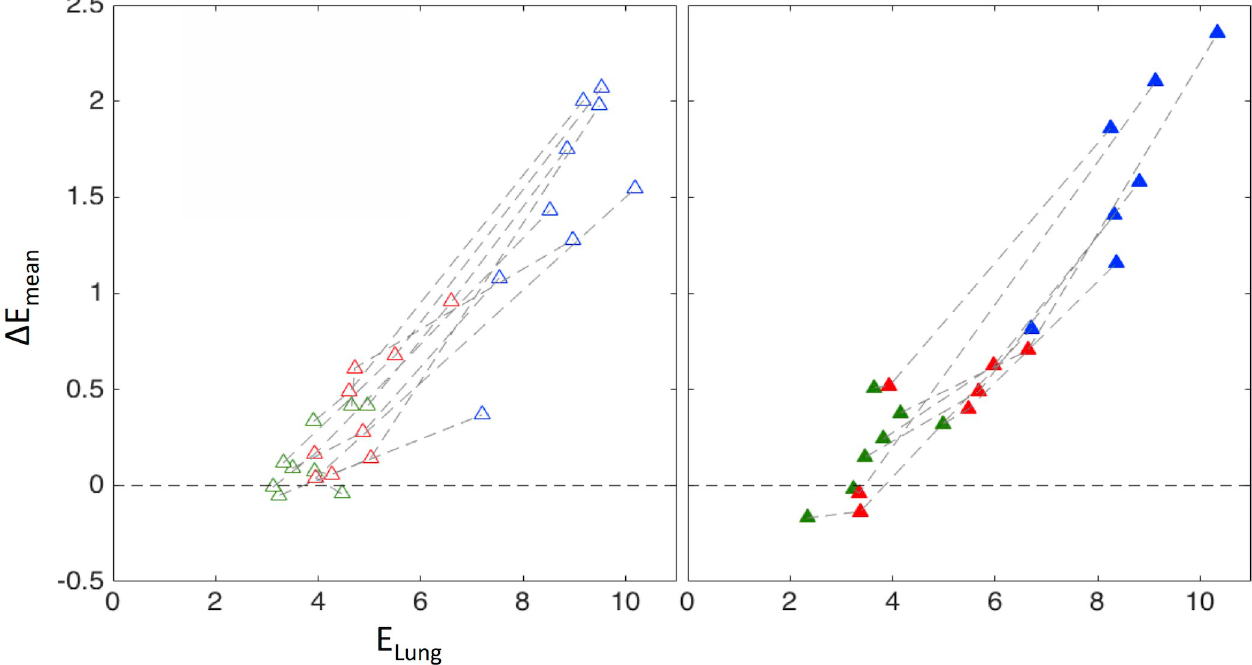
Fig 4. Mean difference between sub-lobar and peribronchial parenchyma expansion, adjusted by height difference, Δ E average lung expansion, E Lung , in three conditions for the group of subjects without asthma (NA, left) and with asthma (AS, right). The conditions are Baseline at MLV (Green), post MCh at MLV (Red), and post at TLC (Blue). Points for each subject are connected with dashed lines. There is no apparent difference in the behavior of both